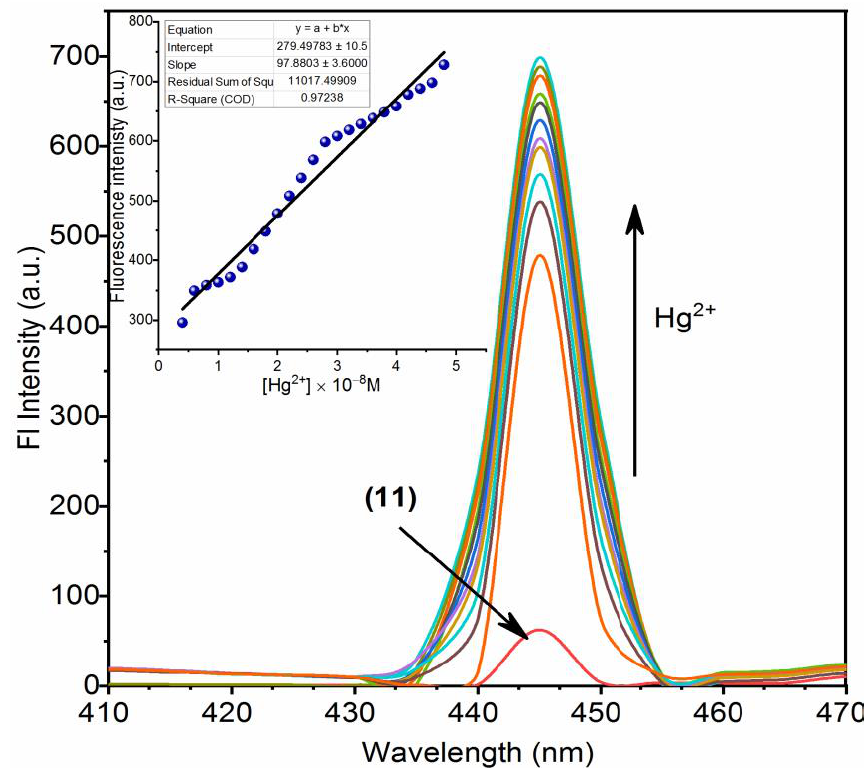
Figure 3. Emission spectra of the sequential addition of Hg 2+ ions (4 nM – 50 nM) in 10 ppm of nano- composite (11) ; inset linear fitting pot to calculate LOD and LOQ @445 nm.